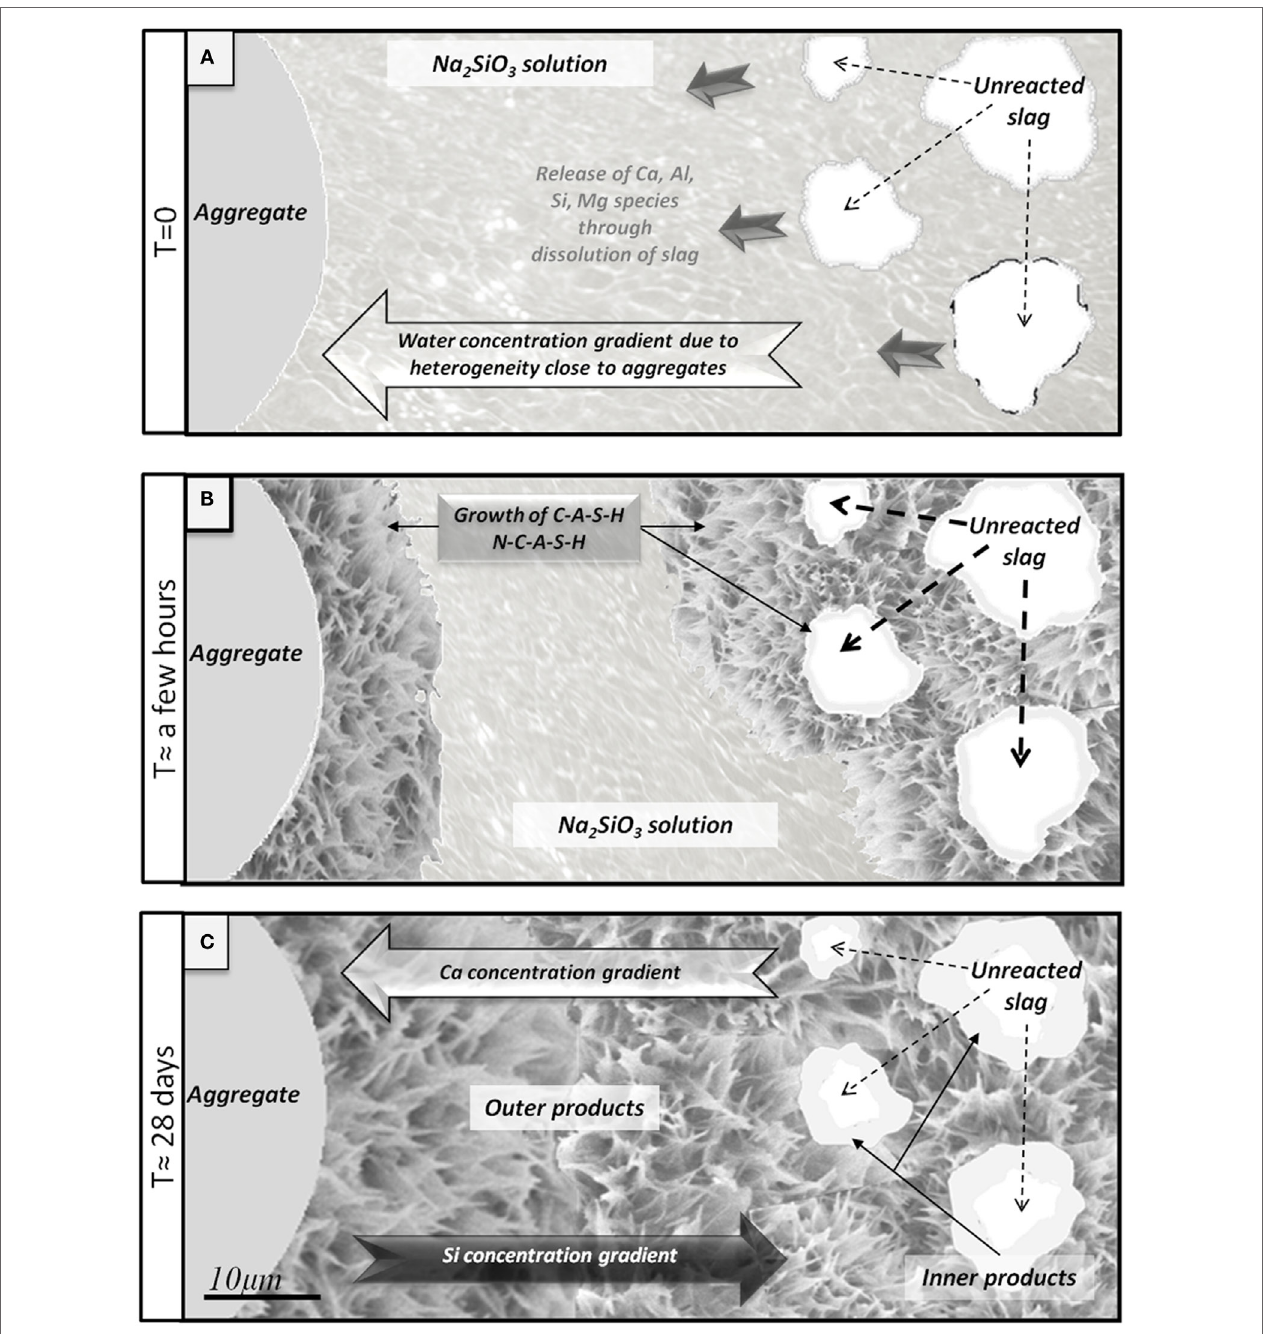
FigUre 9 | schematic diagram of interfacial transition zone formation in an alkali-activated slag binder . (a) Initial early release of ions via slag dissolution. (B) Growth of C-A-S-H and N-C-A-S-H on slag and aggregate. (c) Situation of the paste after 28 days: residual unreacted slag, inner products around slag richer in calcium, and outer products around the aggregate richer in